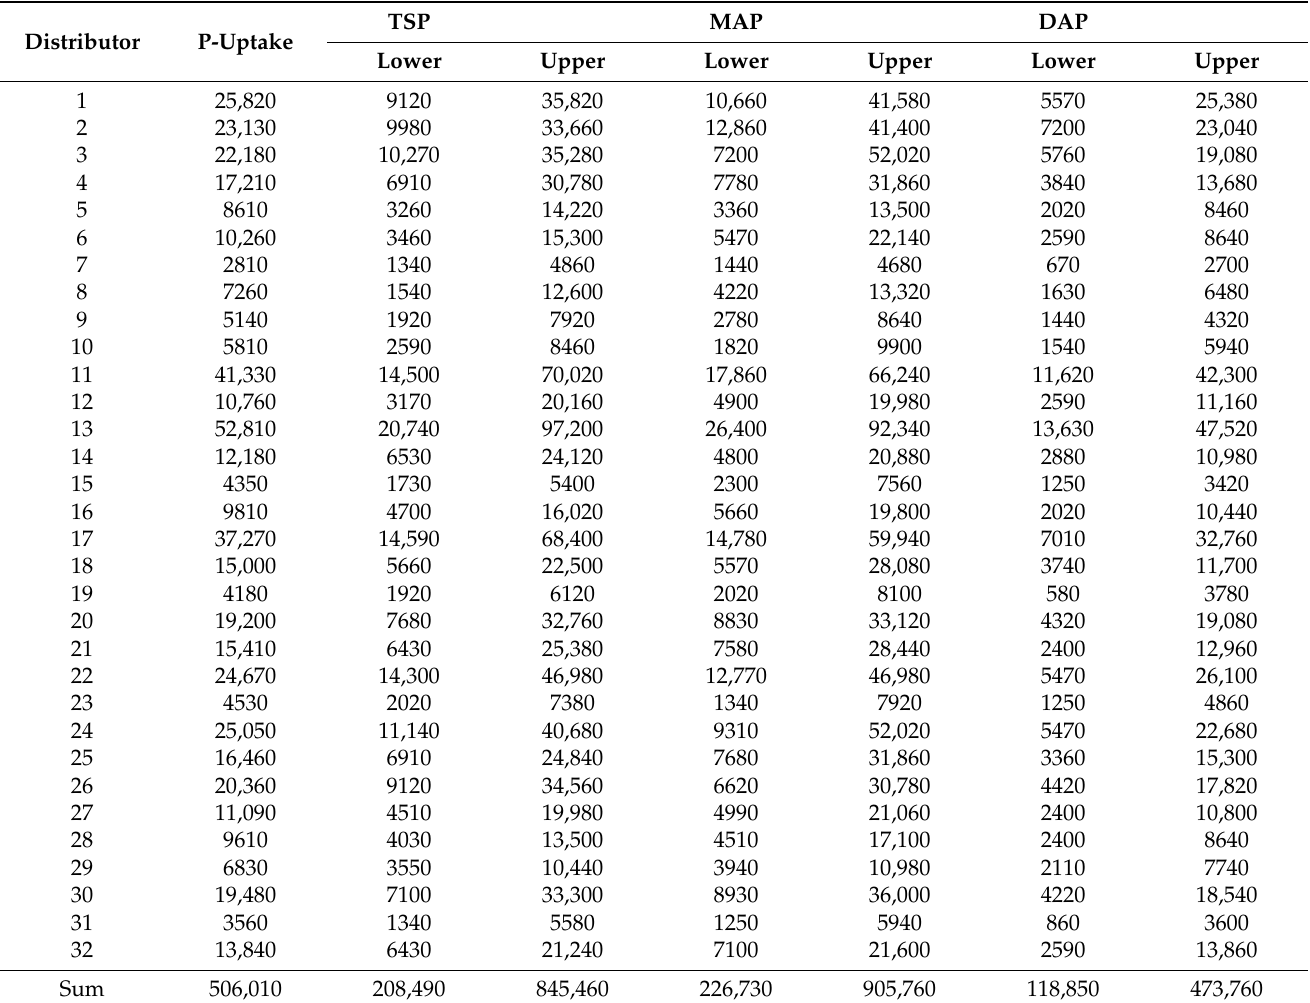
Table 2. Demands of the distribution centers in terms of the total P-uptake and lower/upper bound on the required fertilizers (ton/year).